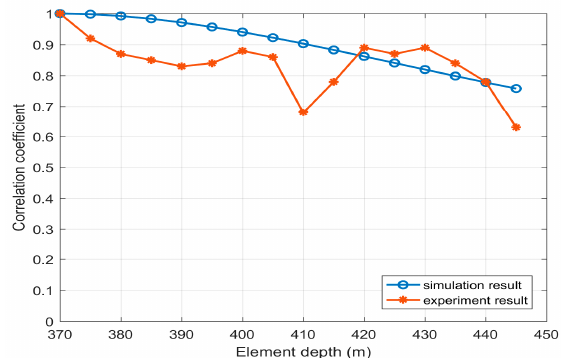
Figure 12. Comparison result of signal correlation coefficient.